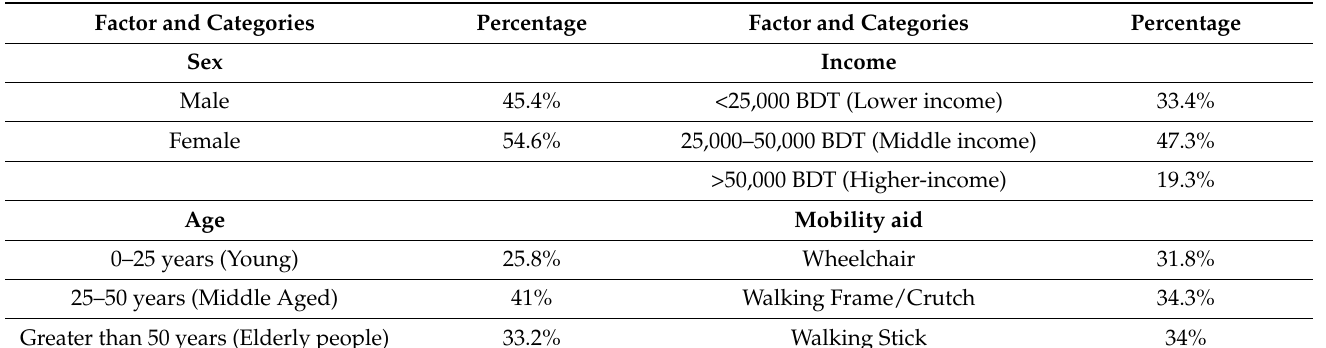
Table 1. A brief overview of the stratification of samples and ordinal scaling of